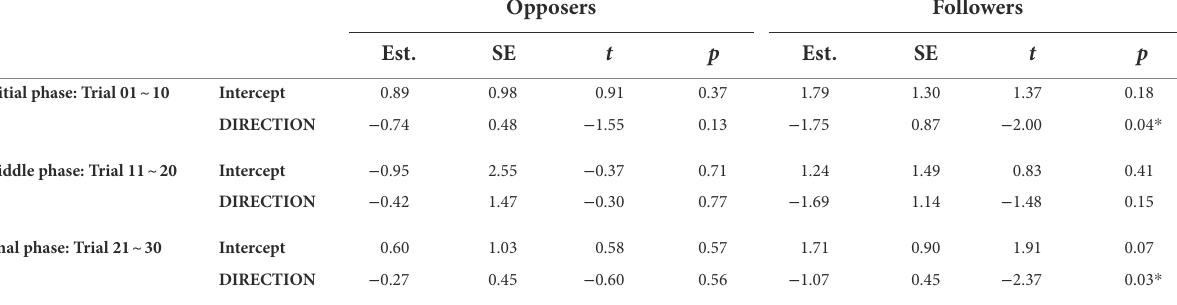
TABLE 3 Results from the three-class latent class regression models using pitch-shift stimulus direction as a covariate variable.